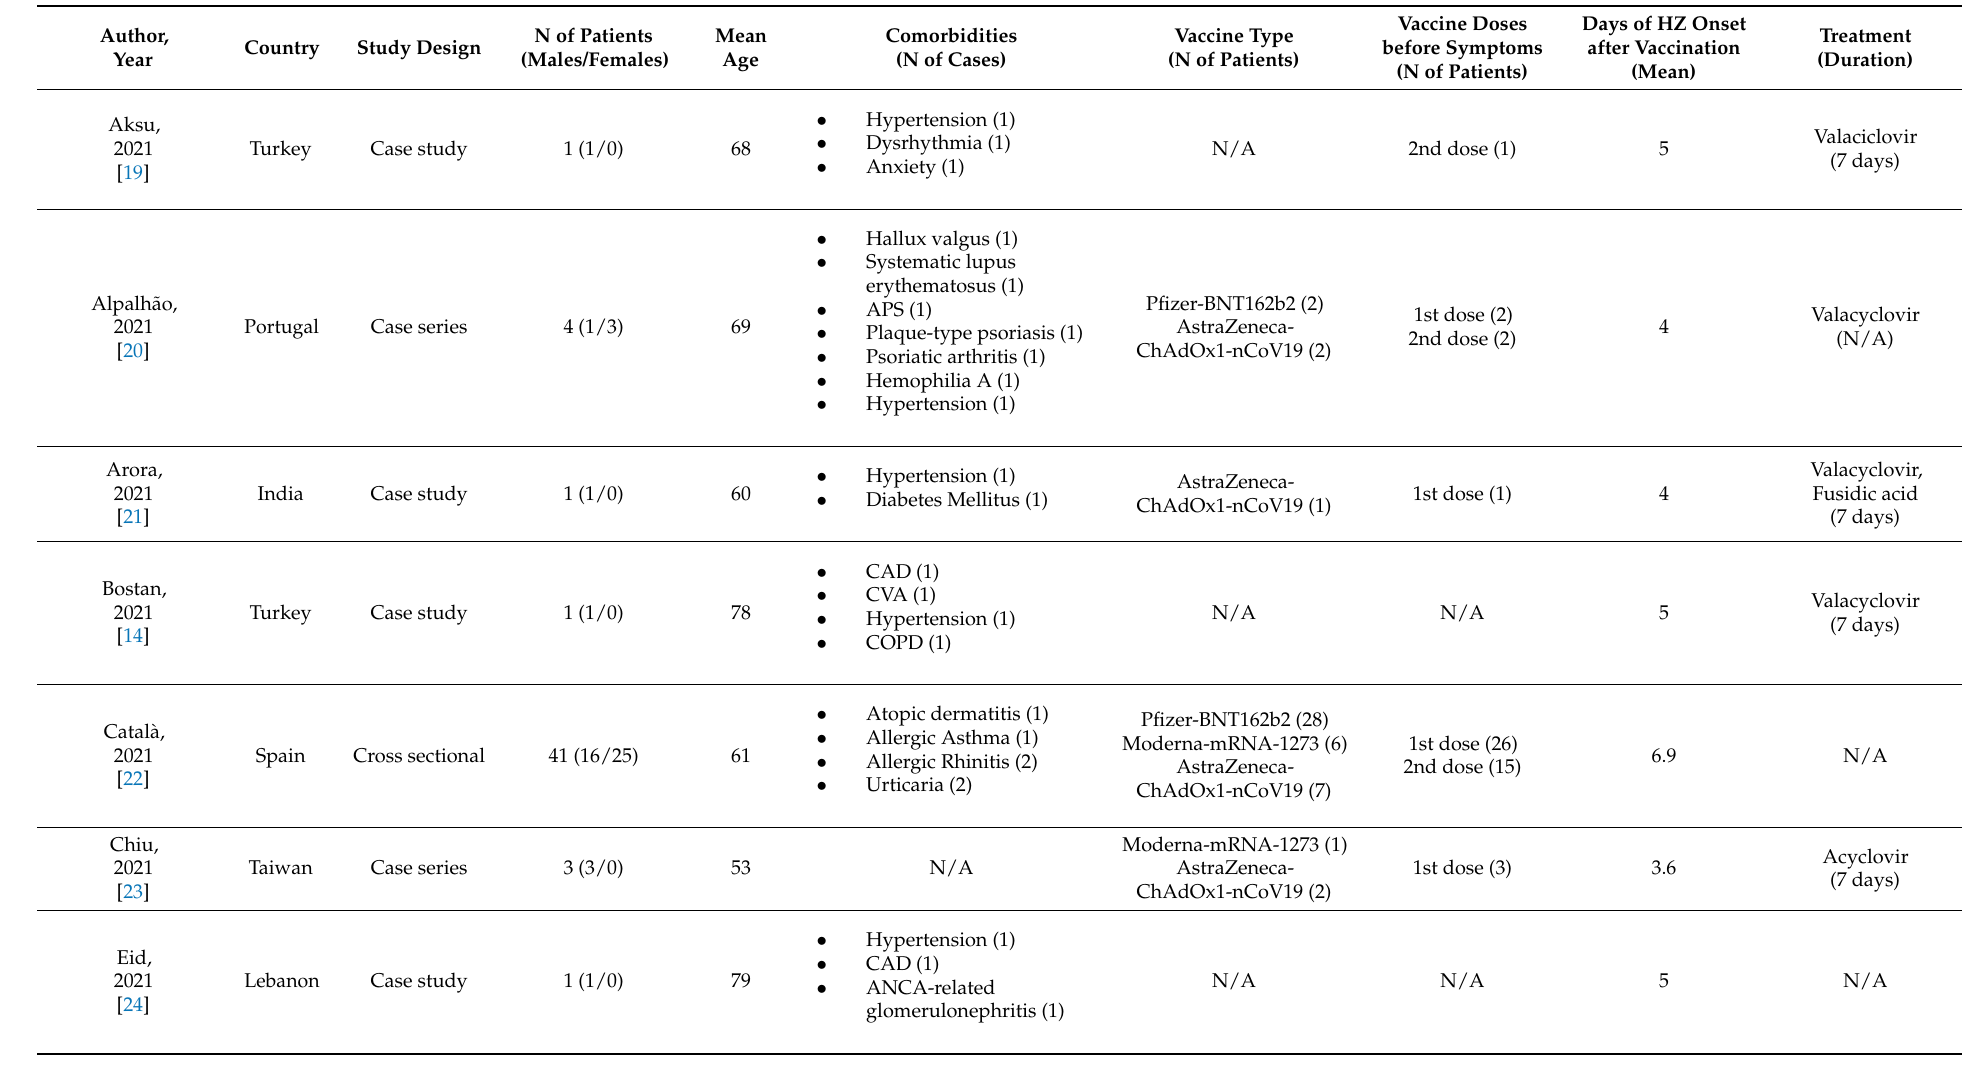
Table 1. Characteristics of the included